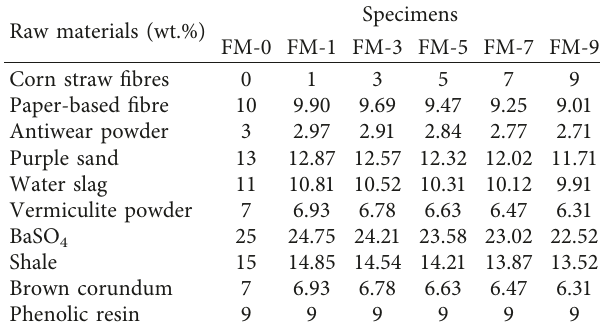
Table 1: Details of composite designation and composition. Raw materials